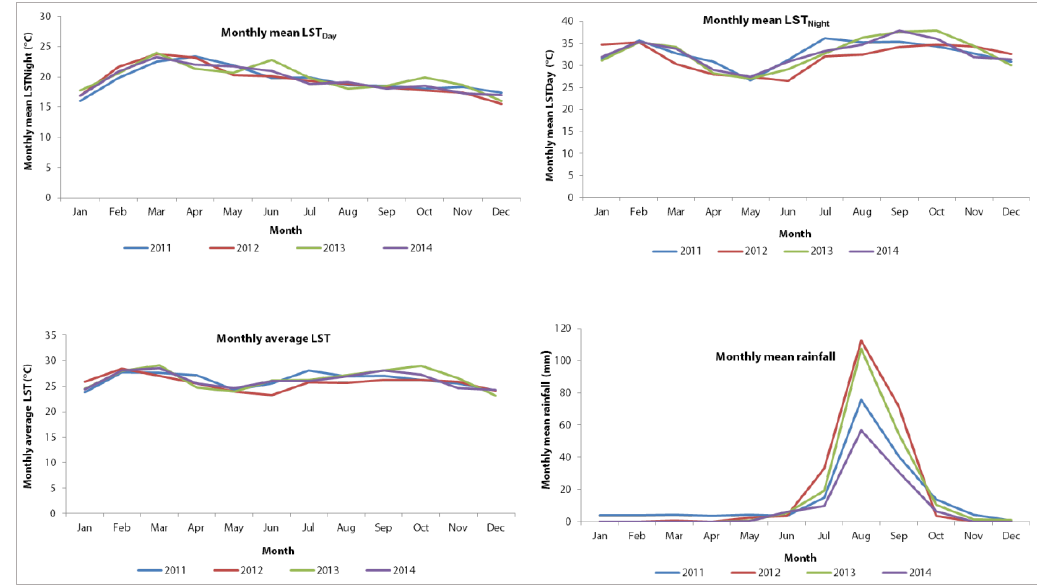
Figure 2. Distribution of mean monthly climatic variables in Mbour, Senegal over a four-year period from January 2011 to December 2014. Upper row: Distribution of mean monthly land surface temperature (LST Day ) and Night (LST Night ), by month and year, over the period 2011–2014. Lower row: Distribution of monthly average land surface temperature and monthly mean cumulative rainfall, by month and year, over the period 2011–2014.